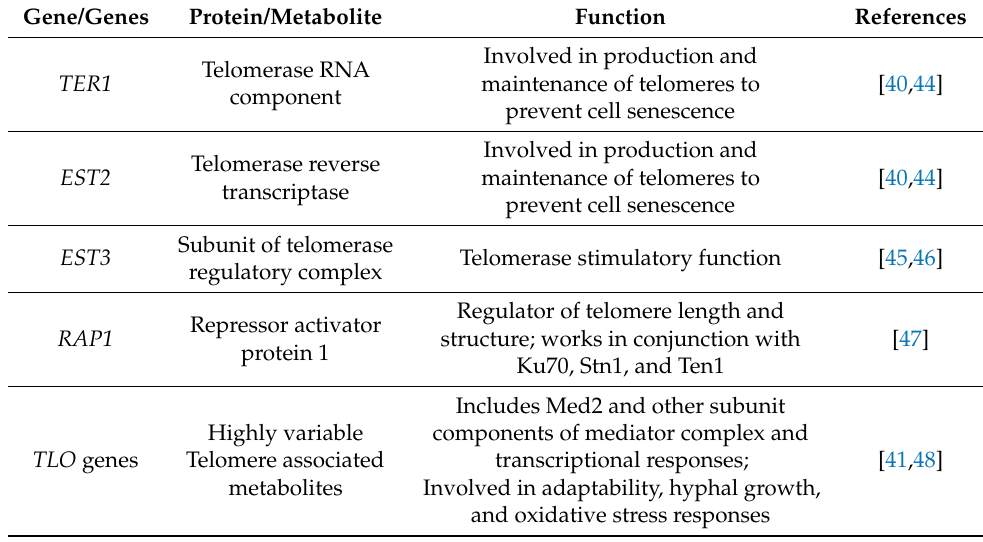
Table 3. Subtelomeric genes that increase pathogenicity in C. albicans